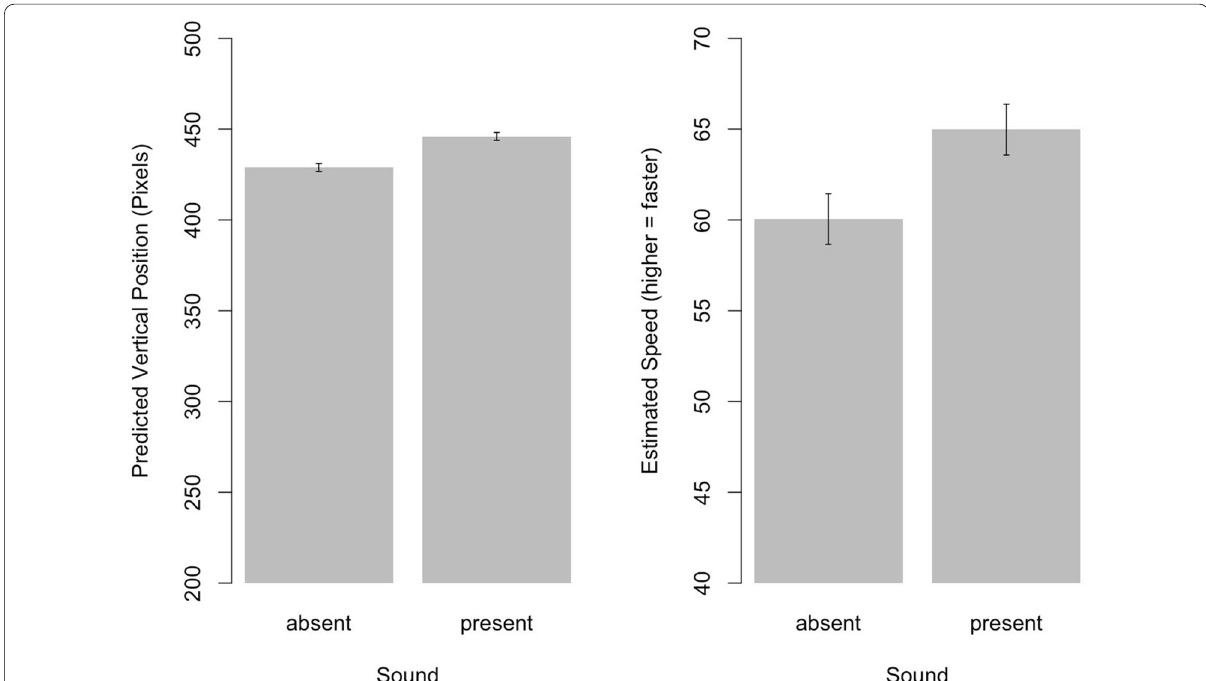
Fig. 2 Effects of sound present vs. sound absent on the anticipation judgments of the ball’s landing location in the longitudinal (i.e., vertical) axis (left panel) and on speed judgments (right panel). Higher pixel values indicate longer predicted trajectories, that is, closer to the baseline. Error bars indicate 95% confidence